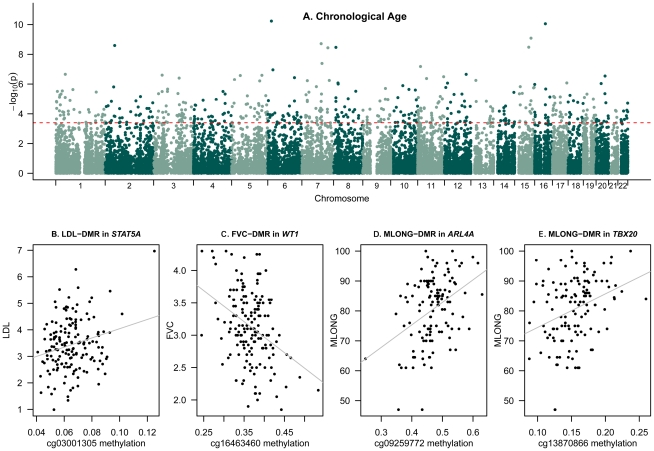
Epigenome-wide association scans of age and age-related phenotypes.(A) Genome-wide results for chronological age at FDR = 5% (a-DMRs). Red dashed line corresponds to FDR 5% significance level threshold. (B–E) Peak ap-DMRs were obtained for (B) LDL-DMR cg03001305, (C) lung function (FVC) DMR cg16463460, and maternal longevity (MLONG) DMRs cg09259772 (D) and cg13870866 (E); grey lines correspond to fitted linear regression models on these data.